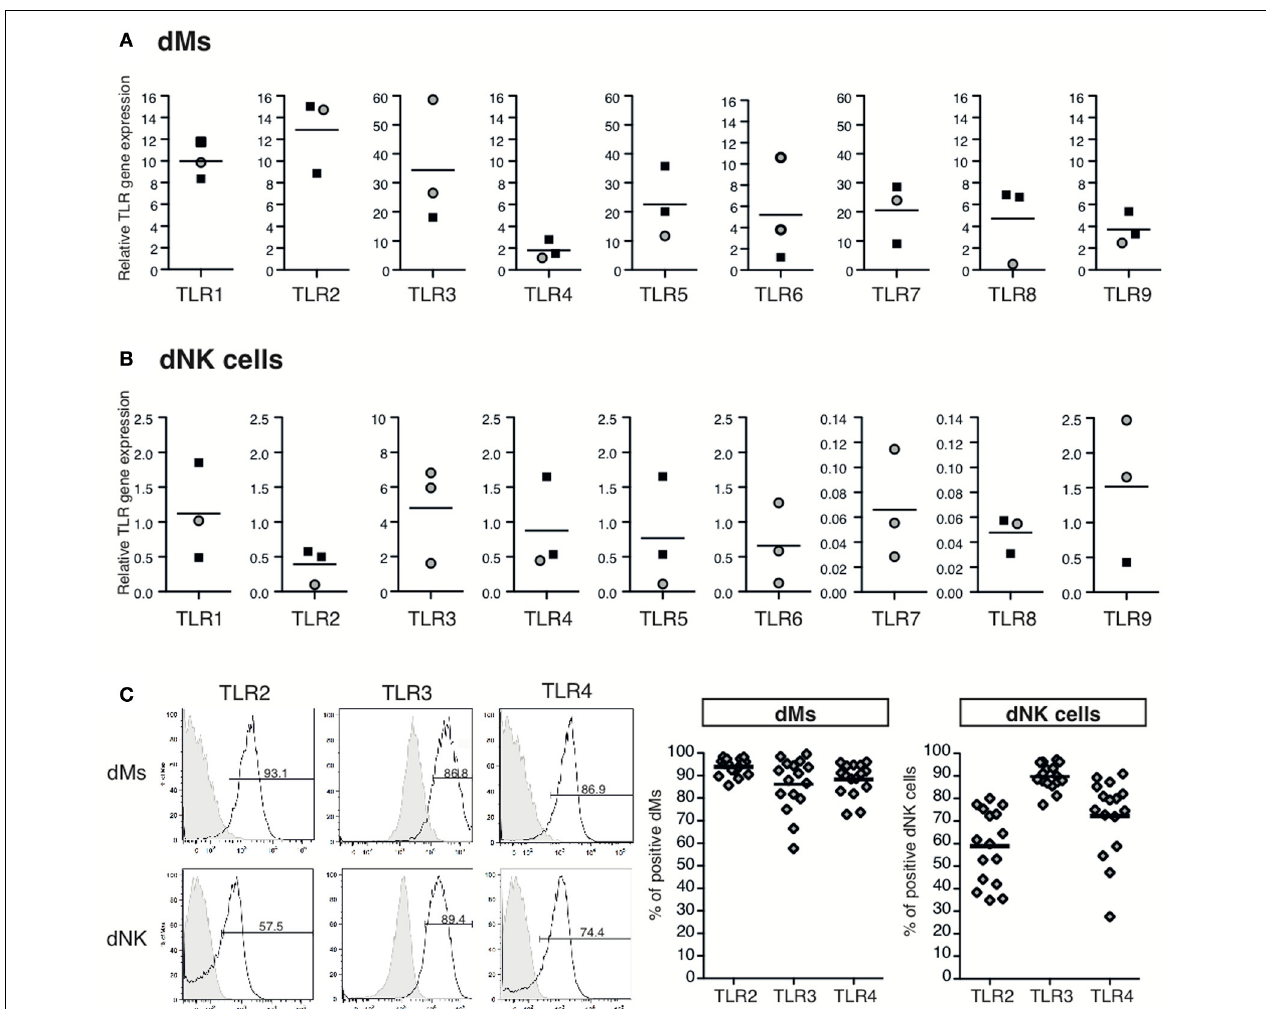
FIGURE 1 | Expression of TLR mRNAs and of TLR2, TLR3, and TLR4 protein by dM and dNK cells. TLR1, TLR2, TLR3, TLR4, TLR5 TLR6, TLR7, TLR8, and TLR9 mRNA expression in purified dMs (A) and dNK cells (B) was quantified by RT-qPCR. Each dot represents one sample, dMs and dNK cells purified by flow sorting or by magnetic beads are depicted by black squares and gray circles respectively. Relative TLR gene expression was determined by the 2 − (cid:2)(cid:2) CT method. TLR gene expression was normalized to the endogenous gene CDKN1B and a decidual mononuclear cell sample was used as reference. TLR2, TLR3,